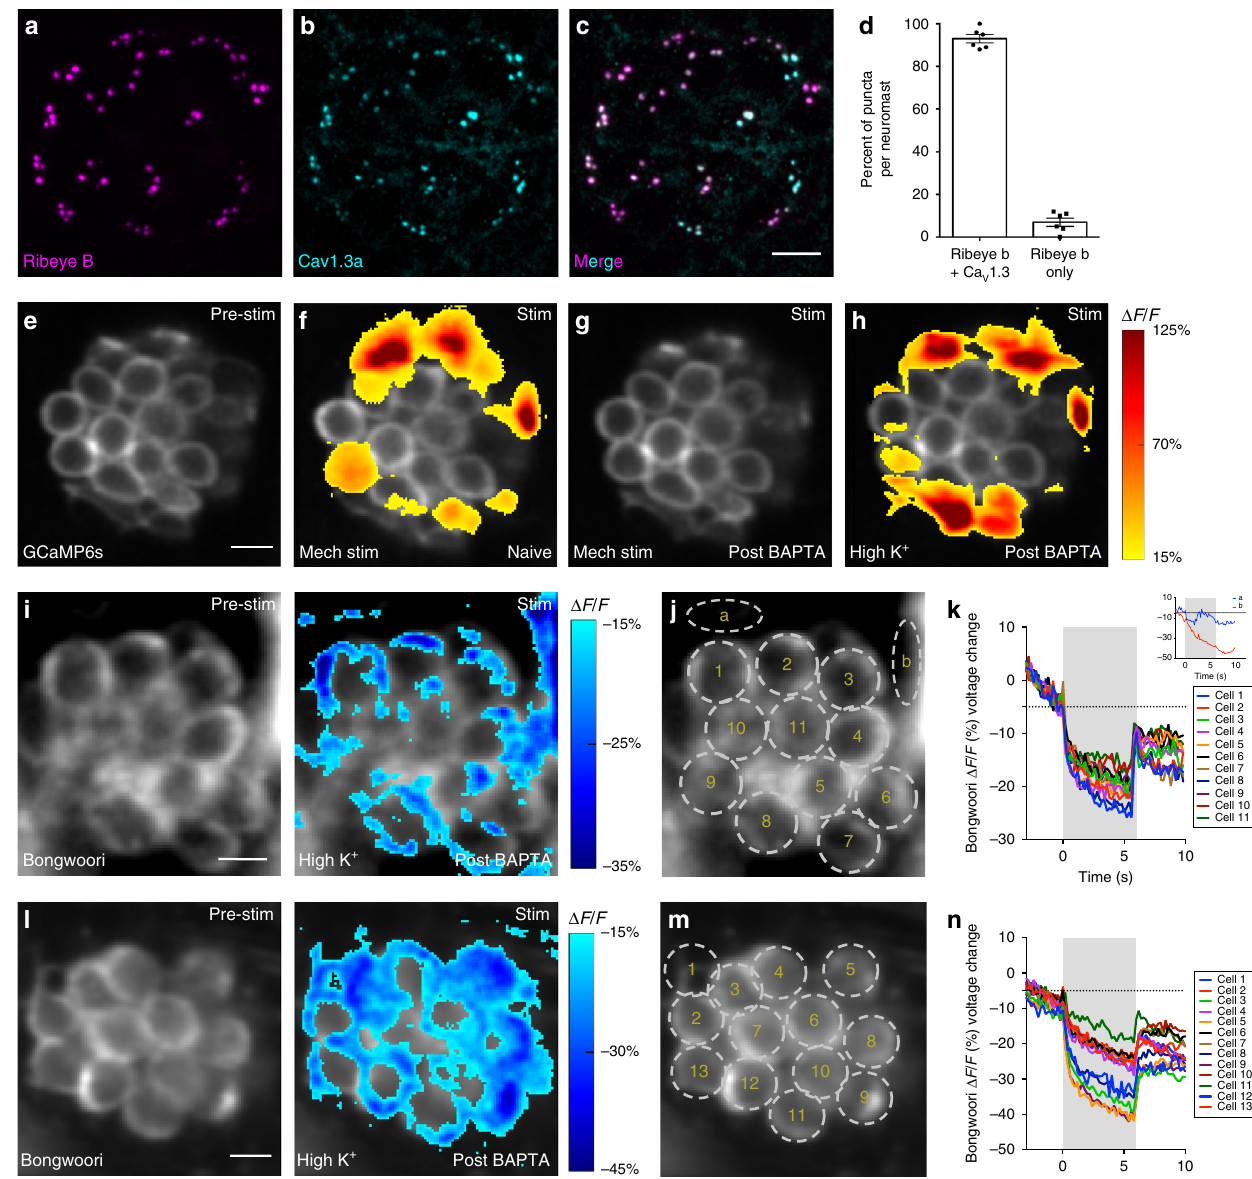
Fig. 6 Depolarization does not activate Ca V 1.3 channels in all cells. a – c Example neuromast with immunostain labeling presynaptic ribbons (Ribeye b, magenta) in a , and presynaptic Ca V 1.3a channels (cyan) in b . Images in a and b are merged in c . d Quanti fi cation of the percent of Ribeye b positive ribbons per neuromast that colocalize with Ca V 1.3a (93.00%± 1.93, n = 10 neuromasts). e – h Representative neuromast demonstrating spatial patterns of hair-cell presynaptic GCaMP6s Ca 2 + signals during mechanical and high K + stimulation. Signals are colorized according to the Δ F / F heat map and superimposed onto baseline GCaMP6s image ( e ). f A subset of cells shows presynaptic Ca 2 + signals in response to a 2-s 5 Hz mechanical stimulus. g All mechanical responses are eliminated after BAPTA treatment. h After BAPTA treatment, to depolarize hair cells, high K + was applied (via the fl uid jet). High K + application activates the same cells as the original mechanical stimulus ( f ). i , l Example neuromasts demonstrating spatial patterns of hair-cell Bongwoori voltage signals during high K + stimulation. Spatial patterns of Bongwoori voltage signals during high K + stimulation are colorized according to the Δ F / F heat map and superimposed onto baseline Bongwoori image ( i , l , left panels). k , n Using 5 µ m ROIs shown in j , m , all cells show depolarization in response to high K + application. Inset in k demonstrates that changes in Bongwoori signals in the background skin pigment (ROIs a , b ) do no correlate with the stimulus. Scale bars = 5 μ